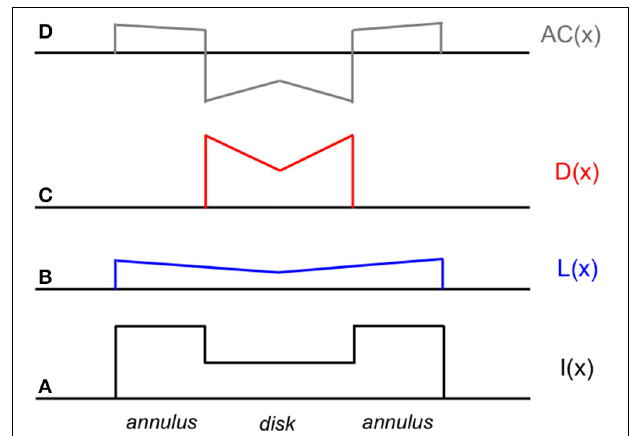
FIGURE 5 | Schematic diagram of neural activations at various stages of the cortical lightness computation model in response to a decremental disk-annulus stimulus. From bottom to top (following the convention of Figure 3 ). (A) One-dimensional cross-section of the luminance profile I(x) of a decremental disk-annulus stimulus. (B) The spatial pattern of activation L(x) of lightness neurons in V4 in response to the stimulus in (A) . (C) The pattern of activation D(x) of darkness neurons in V4 in response to the same stimulus. (D) The pattern of activation AC(x) at some subsequent stage of neural processing (likely located in cortical area TEO or TE) at which the activation pattern D(x) is subtracted from L(x) to compute perceived reflectance, or achromatic color. Note that the activation patterns L(x) and D(x) are constructed solely from induction signals based on edges pointing in the direction of the disk center. The rationale for excluding other edge-based induction signals from the computation of disk lightness is discussed later in the paper. Note also that the predicted lightening of the disk center, illustrated as a local peak of activity in the AC(x) activation pattern at the location of the disk center is observed in actual experiments (i.e., Rudd and Zemach, 2004; not previously reported), although the spatial profile of the lightened region has more the form of an inverted meniscus, as would be predicted by a model in which the receptive field profiles of the lightness and darkness neurons in V4 fell off exponentially, rather than linearly, with distance from the receptive field